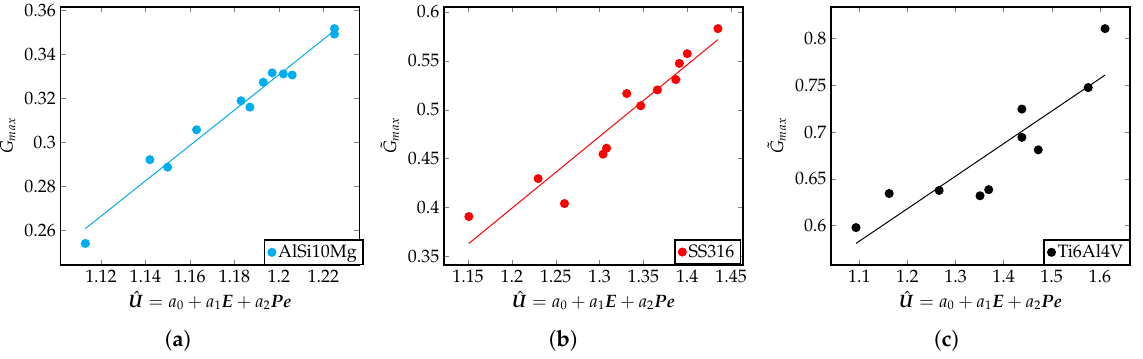
Figure 8. Dimensionless temperature gradient ( G ) with the ˆ U for different alloys. Plots corresponding to IN718 and AZ91D alloy material can be found in Figure S6 of the Supplementary Information. Each point in these plots represent a single simulation result for the relevant quantities plotted, and is obtained from the FEM